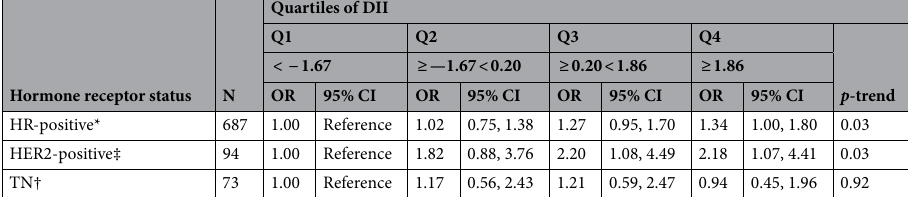
Table 5. Odds Ratios (ORs) and 95% Confidence Intervals (CIs) for the association between Dietary Inflammatory Index (DII) and breast cancer by Hormone Receptors Status. The CECILE study, France, 2005– 2007. *HR-positive: Hormone receptor positive tumors, i.e. (ER-positive or PR-positive) and HER2-negative. ‡ HER2-positive regardless of the ER or PR status. † TN triple negative (ER-negative and PR-negative and HER2-negative). p- trend determined from the model using the median value in each quartile as a continuous variable. Odds ratios adjusted for study area, age at reference date, history of benign breast, family history of breast cancer in first-degree relatives, age at menarche, parity, age at first full-term pregnancy, breast feeding, menopausal status, current use of hormone therapy, oral contraceptive use and body mass index.